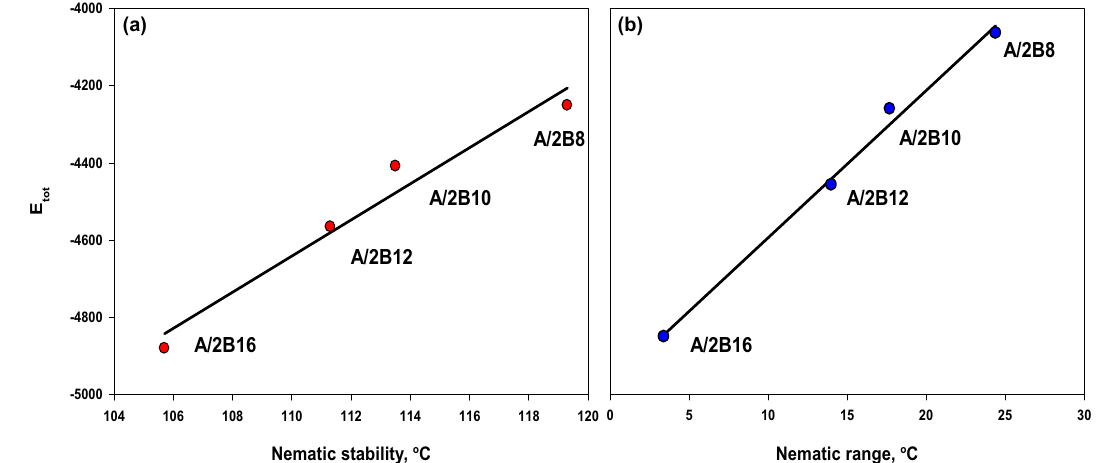
Figure 8. Correlation between the sum of the electronic & themal energies of present complexes A/2Bn with their ( a ) nematic mesophase stability and ( b ) nematogenic range in the conical-shaped geometry.